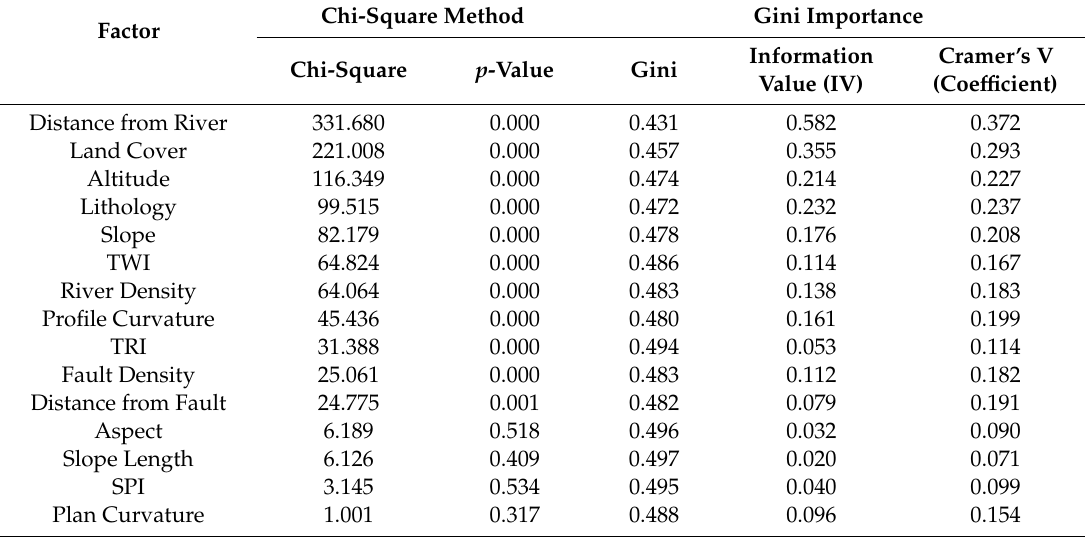
Table 3. Estimated factor importance and ranking using the Chi-square and Gini